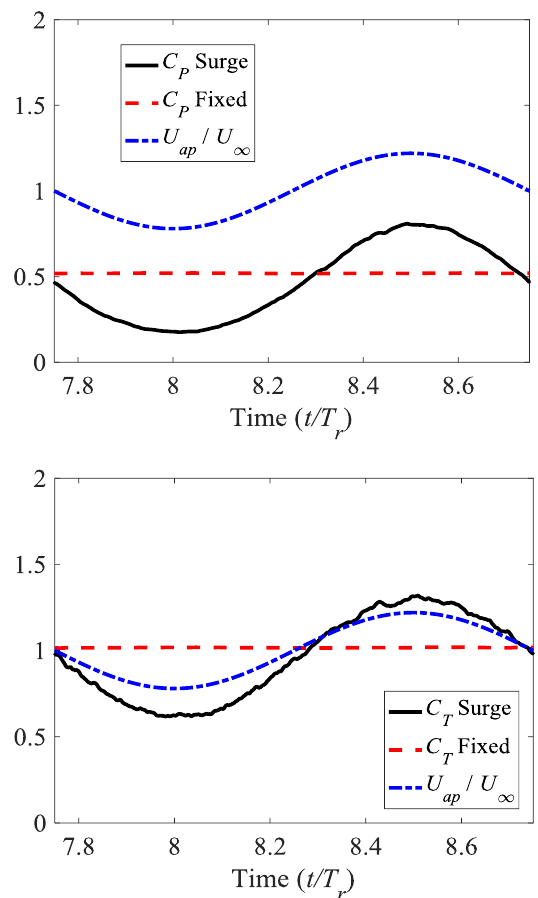
Fig. 4. Time histories of 𝐶 𝑃 (top) and 𝐶 𝑇 (bottom) for a fixed turbine and a surging turbine oscillating at 𝐴 0 = 0.5m and 𝜔 0 = 0.88 rad/s. The turbines rotate at a constant λ = 4.4. The time history of 𝑈 𝑎𝑝 normalized by 𝑈 ∞ is also